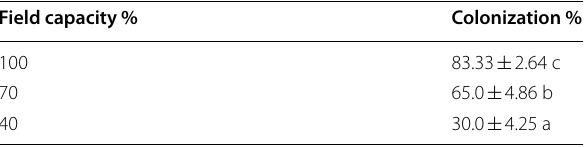
Data showed in the table represent mean SD superscripted with small letter ± Table 2 One‑way ANOVA of growth criteria of Ocimum basilicum under drought and mycorrhiza